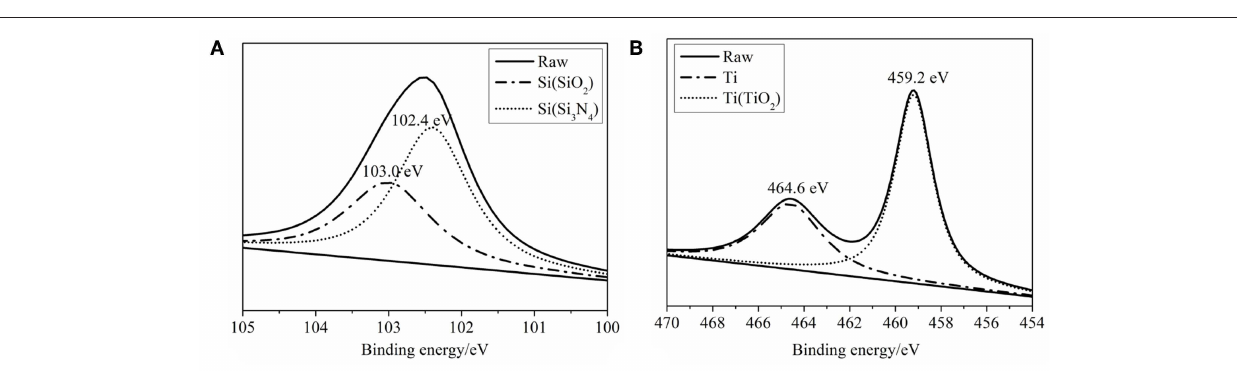
Frontiers in Materials |